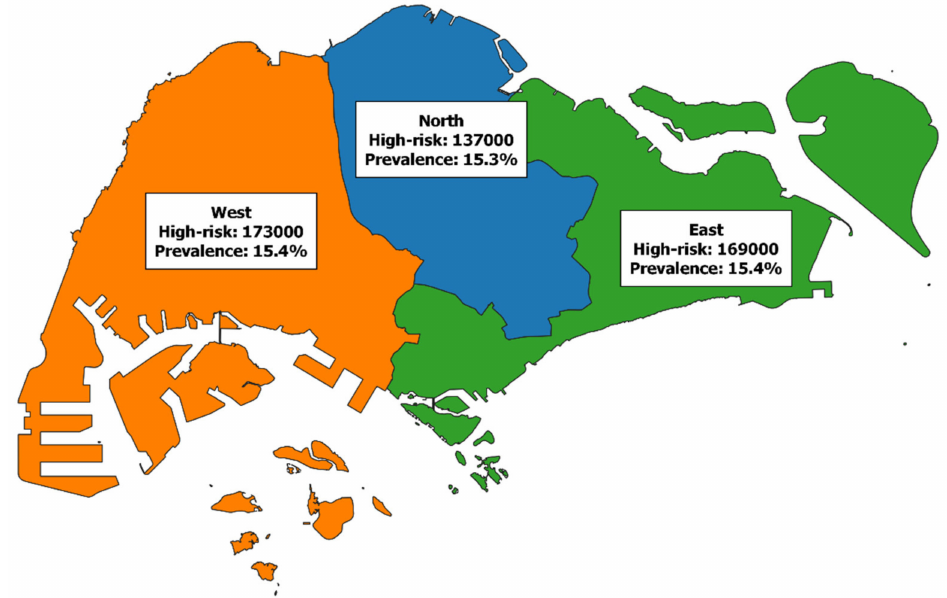
Figure 3. High-risk cases and prevalence by regional health system, rounded off to the nearest thousand. High-risk cases were defined as individuals with at least one chronic